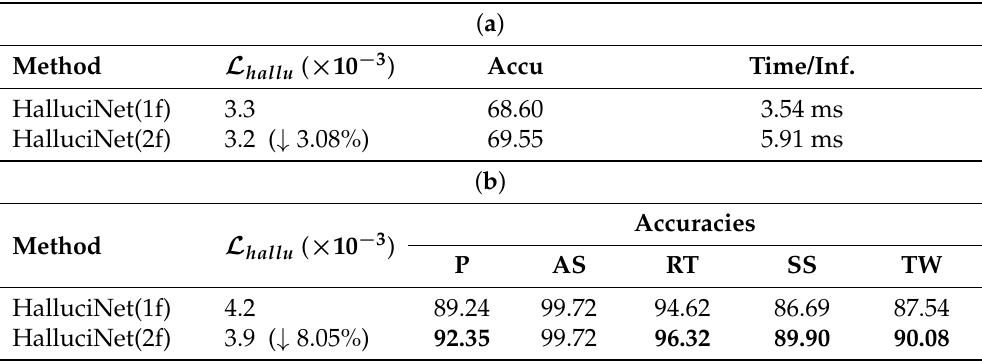
Table 5. ( a ) Single-frame vs. two-frame on UCF-101. ( b ) Single-frame vs. two-frame: MTL-AQA dive classification. L hallu : lower is